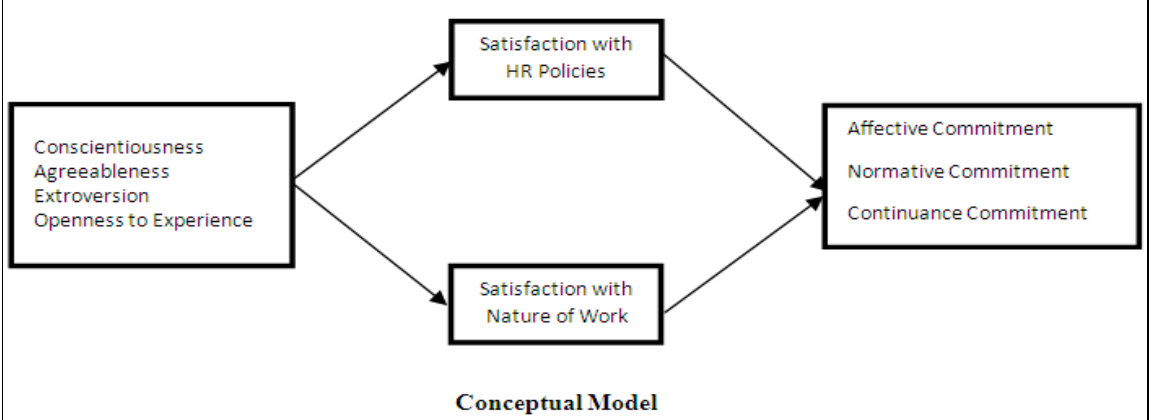
Figure.1. Conceptual